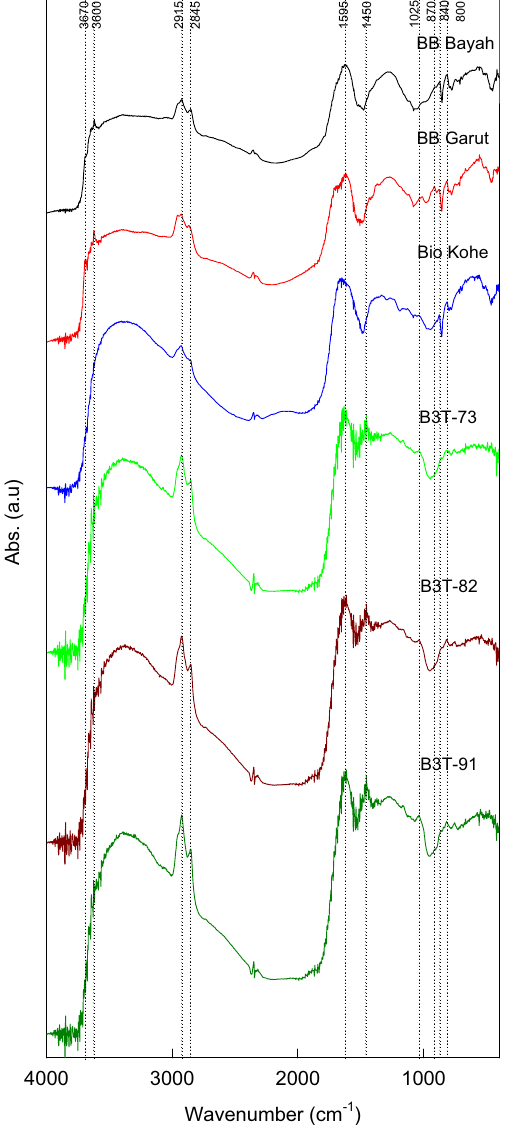
Fig. 8 Typical FTIR spectrogram of a low quality coal sample and bio-coal briquettes product